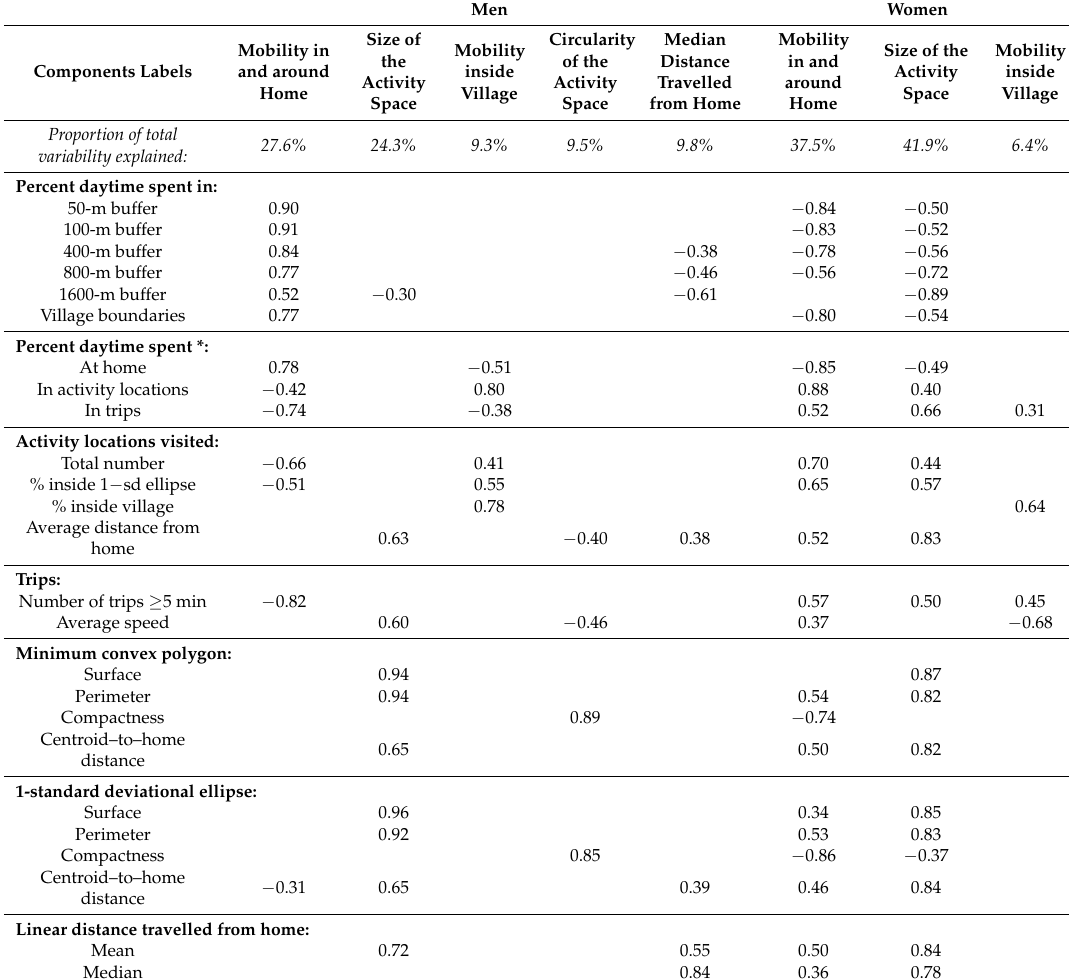
Table 4. Principal component analysis of mobility indicators in men and women.